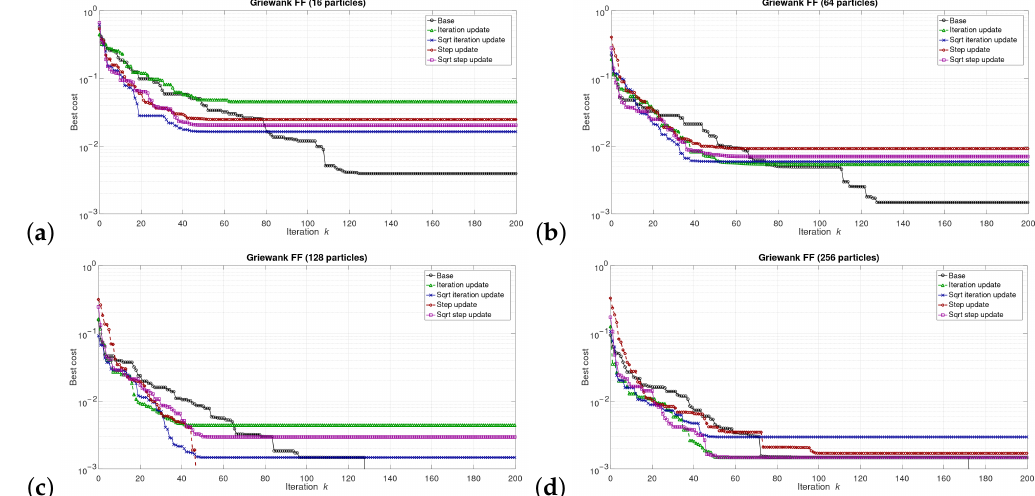
Figure 5. Selected results for Griewank FF for ( a ) 16, ( b ) 64, ( c ) 128, and ( d ) 256 particles.